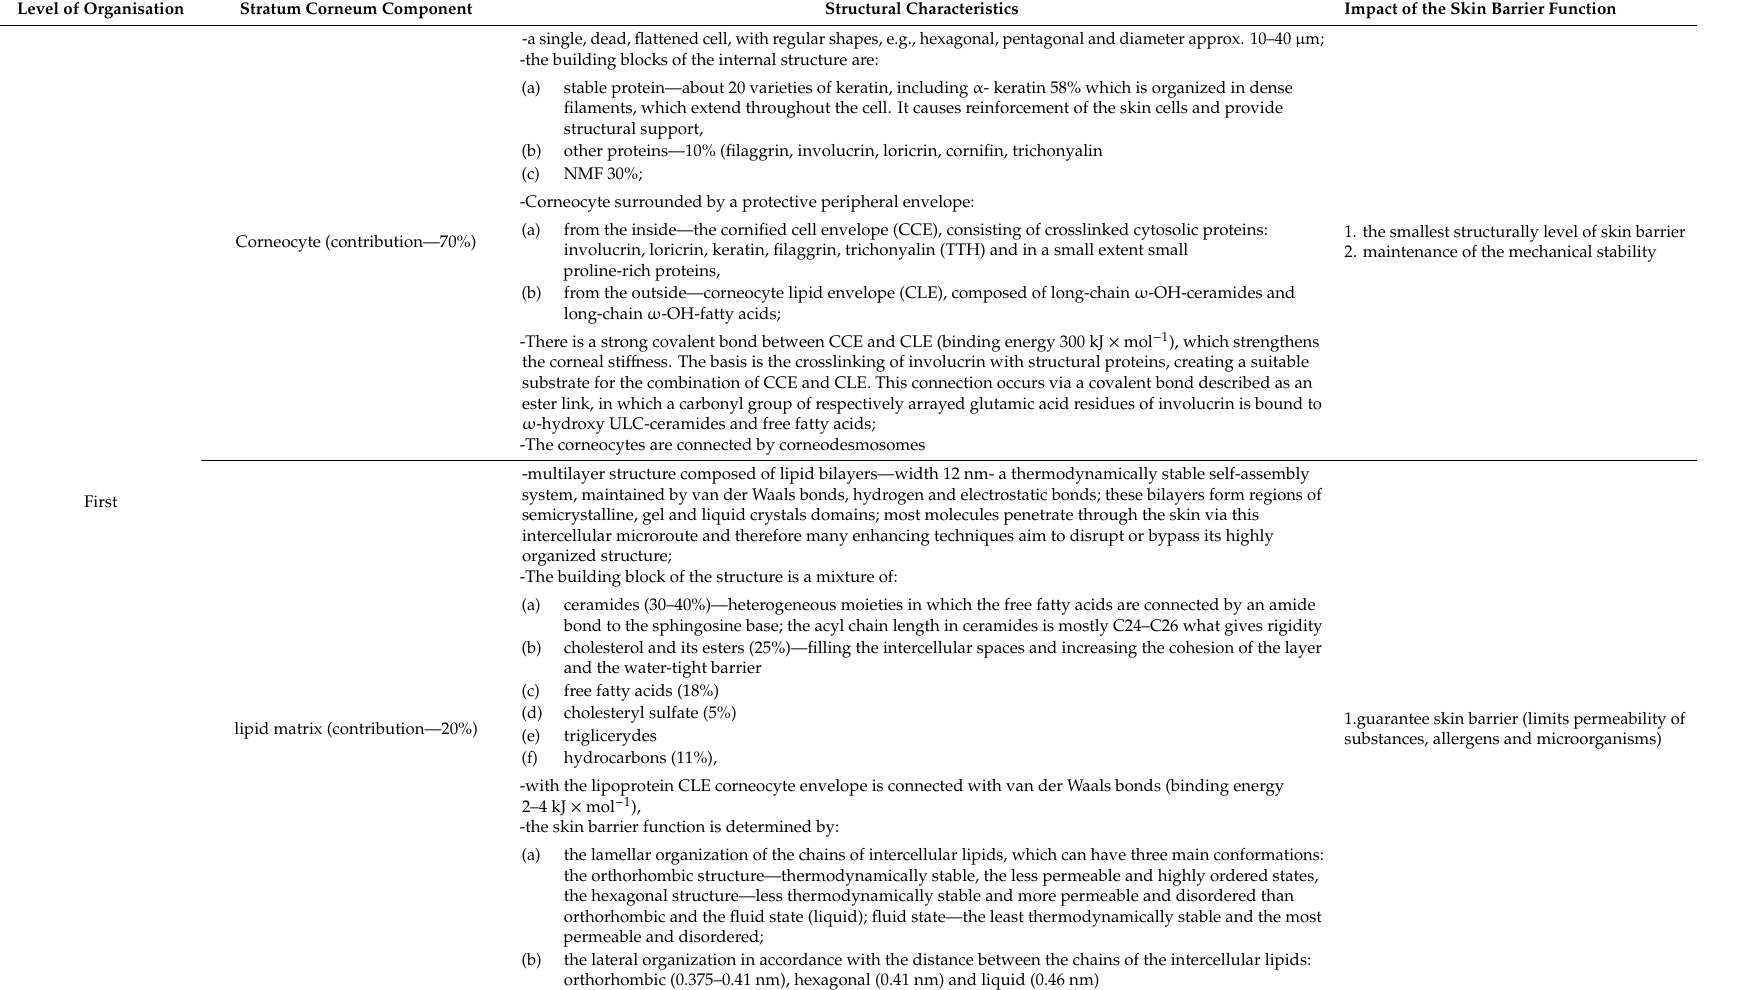
Table 2. Proposal for three-level organization of the stratum corneum barrier